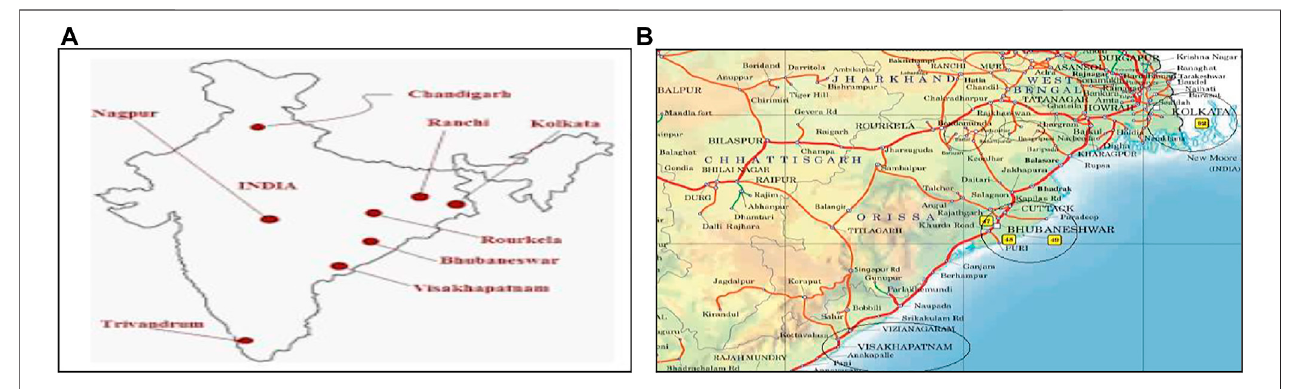
FIGURE 4 | (A,B) Map of Eastern India showing three important stations.